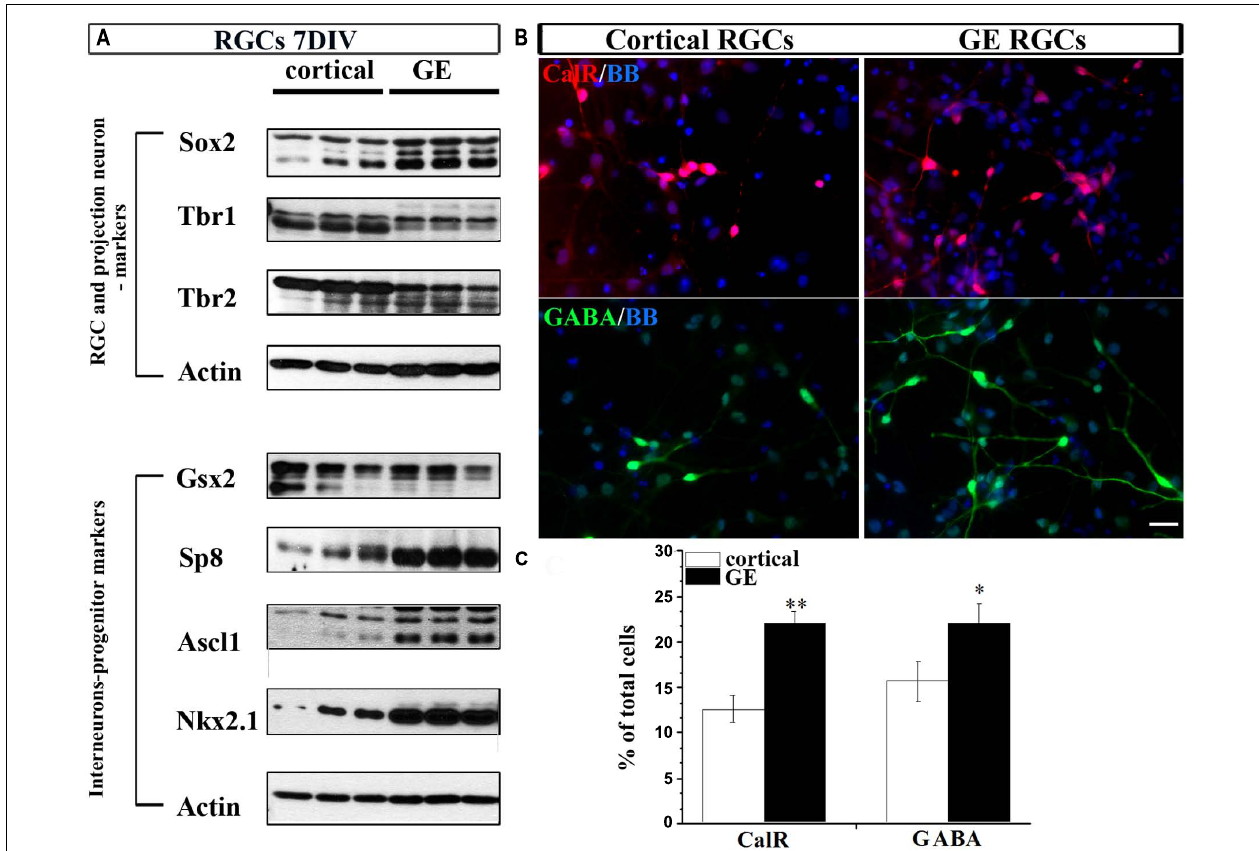
FIGURE 4 | Differentiation of RGCs enriched from cortical or GE regions. (A) Markers of RGCs, projection neurons and interneurons expressed in cortical and GE enriched RGCs after 7 DIV. (B) Representative staining of CalR + (red) and GABA + (green) cells